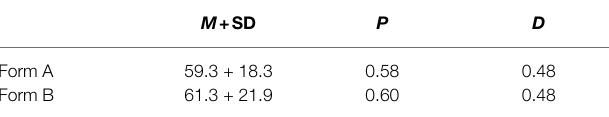
TABLE 4 | The statistical description results of Form A and B.